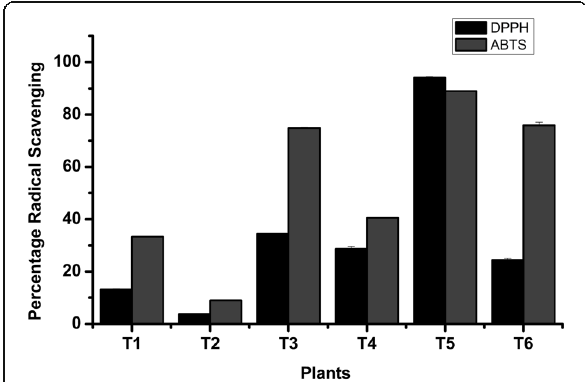
Fig. 1 Percentage radical scavenging of DPPH and ABTS at 100 μ g/ mL plant extracts concentration.